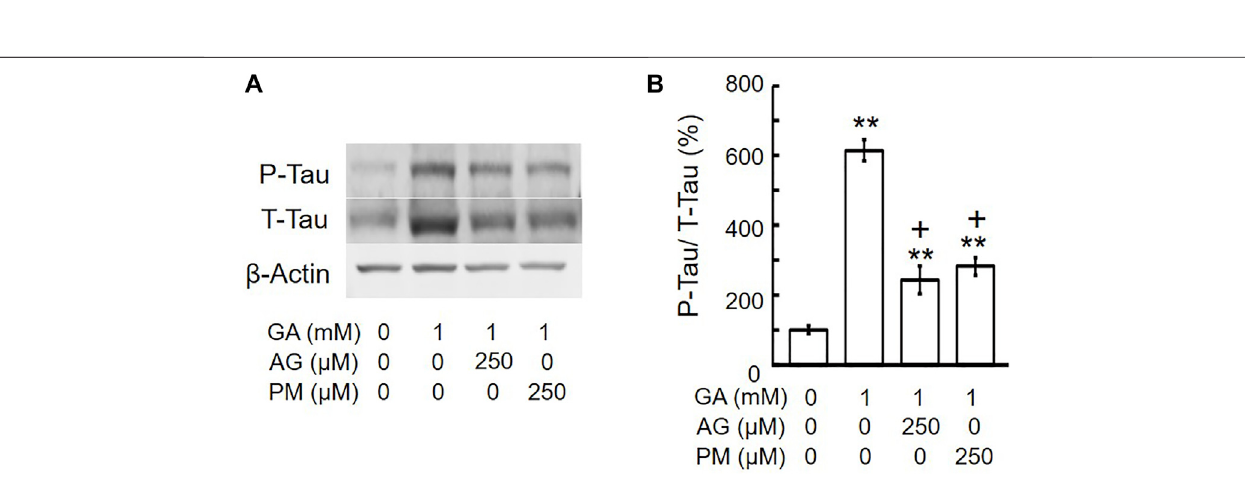
Frontiers in Pharmacology |